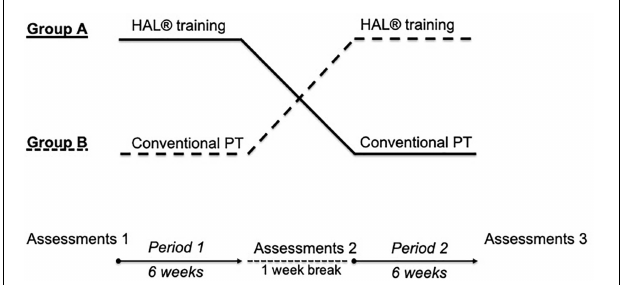
FIGURE 1 | Study design. Two-period, controlled crossover design. Each period included 30 therapy sessions. 1-week break was held between both periods. Before, at crossover and at the end of the study, assessments were done. HAL = hybrid assistive limb, Group 1 = HAL-CPT; Group 2 =